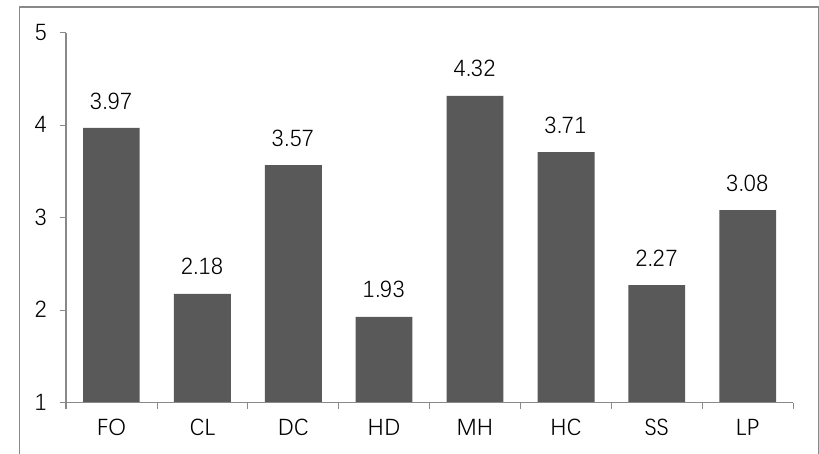
Figure 2. Descriptive statistics of impulsive consumption types.